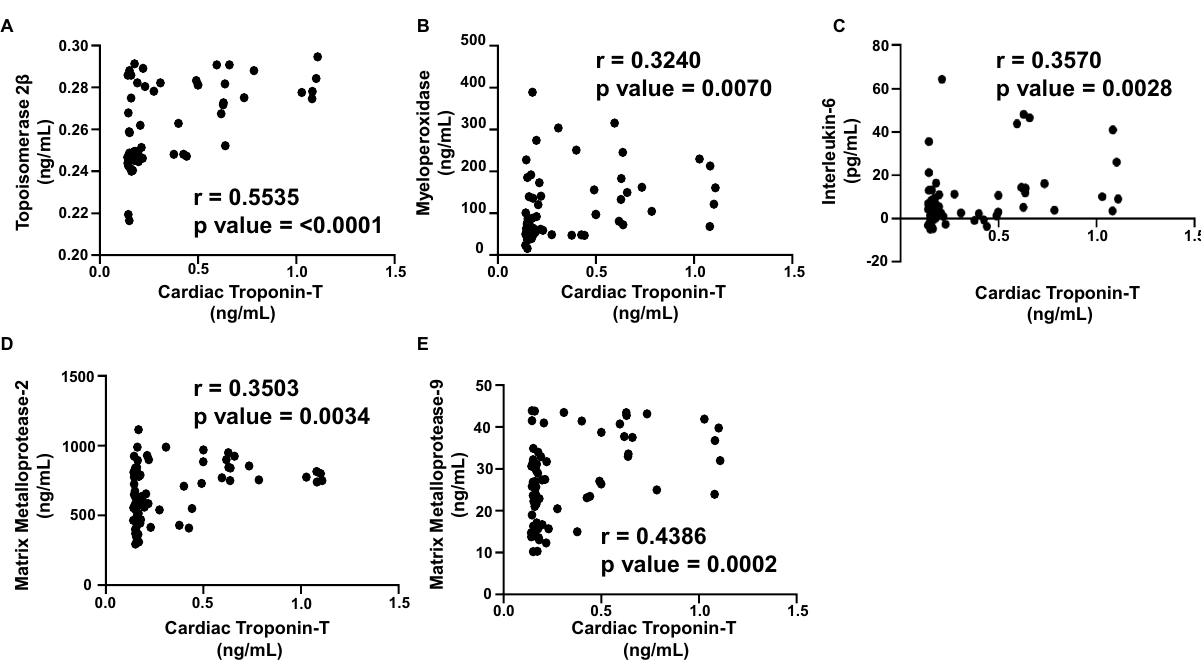
Figure 5. Correlation analysis of plasma biomarkers with high sensitive cardiac troponin T. Correlation was determined using Pearson’s r coefficient using two-tailed p -value to demonstrate significance (alpha = 0.05). Scatter dot plot between cardiac troponin T and plasma biomarkers showing statistical significance, which includes ( A ) Topoisomerase 2β, ( B ) MPO, ( C ) IL-6, ( D ) MMP2 and ( E ) MMP9. Each plot independently shows corresponding correlation coefficient ( r value) and significance ( p